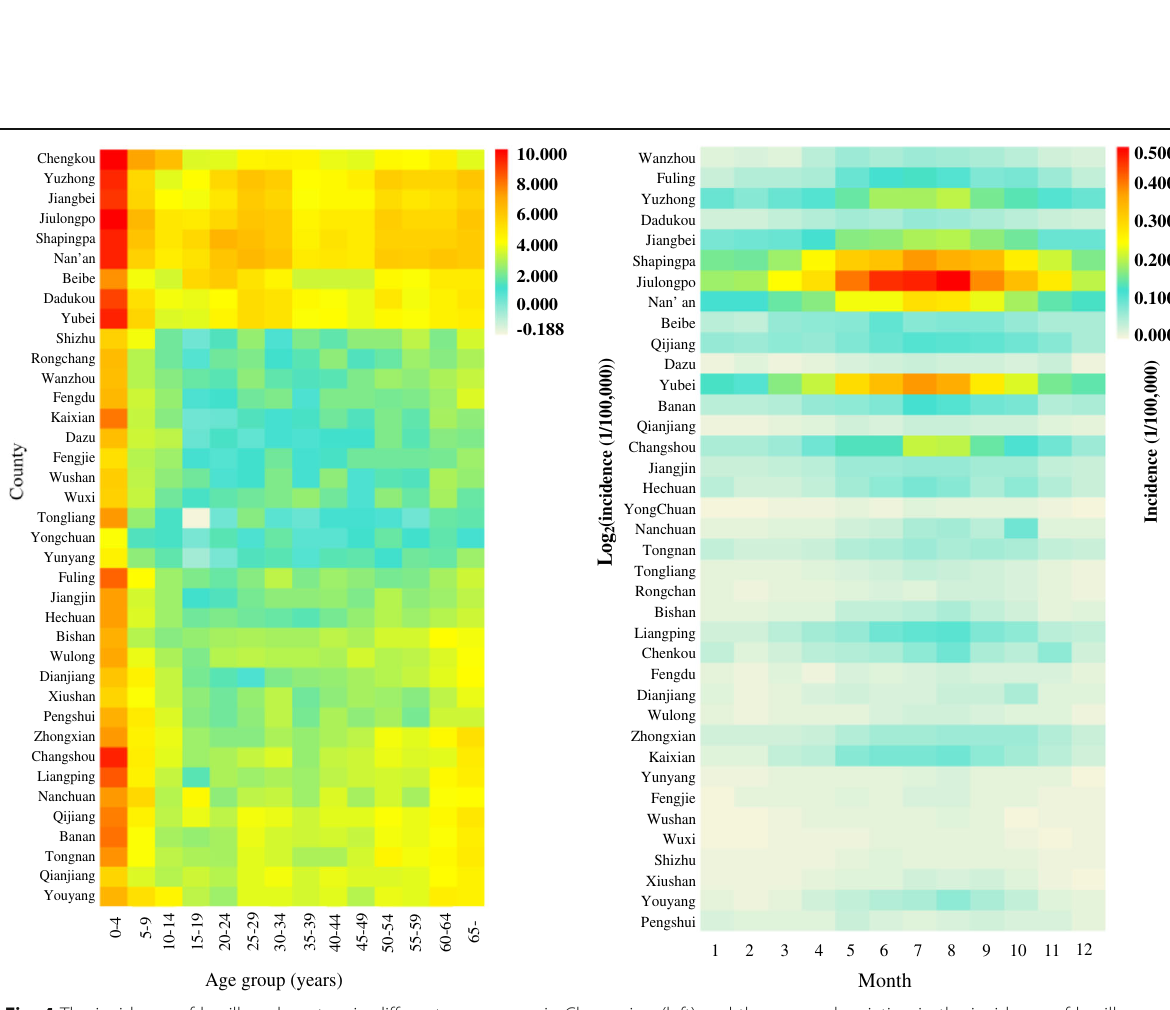
Fig. 4 The incidence of bacillary dysentery in different age groups in Chongqing (left) and the seasonal variation in the incidence of bacillary dysentery in each region of Chongqing